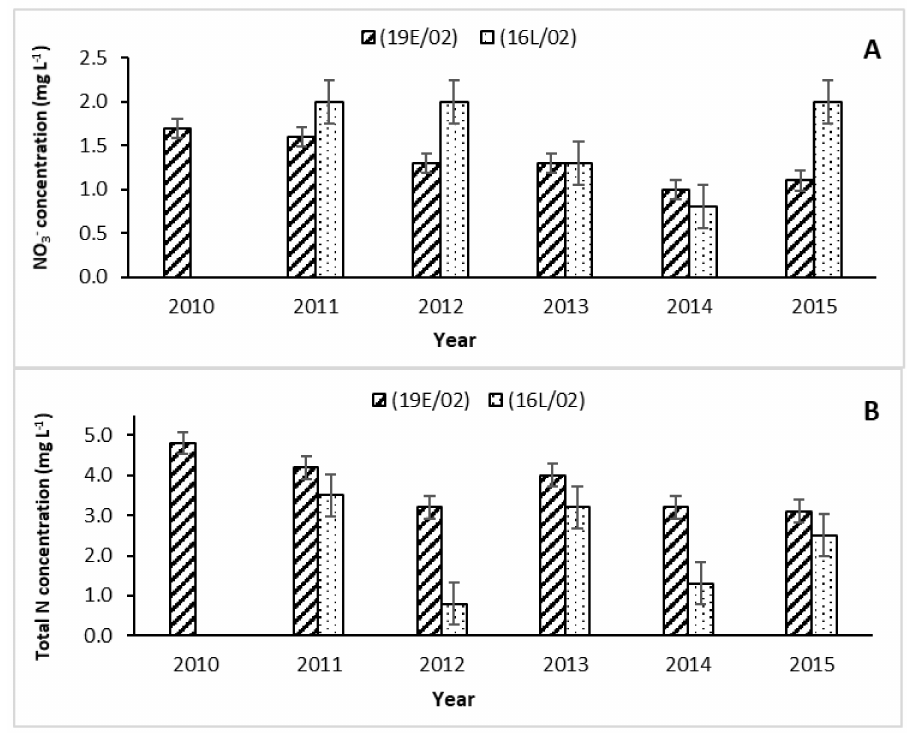
Figure 5. Average NO 3– ( A ) and total N ( B ) concentration (mg L − 1 ) in Tagus River Basin between 2010 and 2015. (Monitoring stations: code: (19E/02)—“Valada do Tejo”; code: (16L/02)—“Monte Fidalgo”)